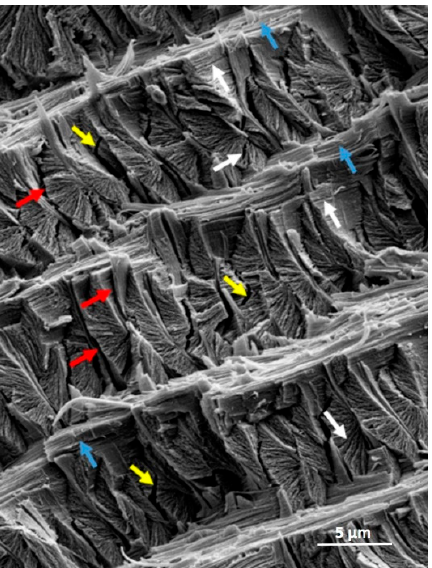
Figure 7. Scanning electron microscope imaging of the scorpion layered endocuticle and Bouligand laminate units (BLU) layers. White, red and blue arrows point to different interfacial failure types (refer also to Figure 5), termed hierarchical interface failures: White , interlamellar (nanoscale) within BLUs; Red , intralayer (microscale) between BLUs; Blue , interlayer (microscale) between layers; Yellow arrows designate non-interfacial (Griffith) internal cracks within BLUs.